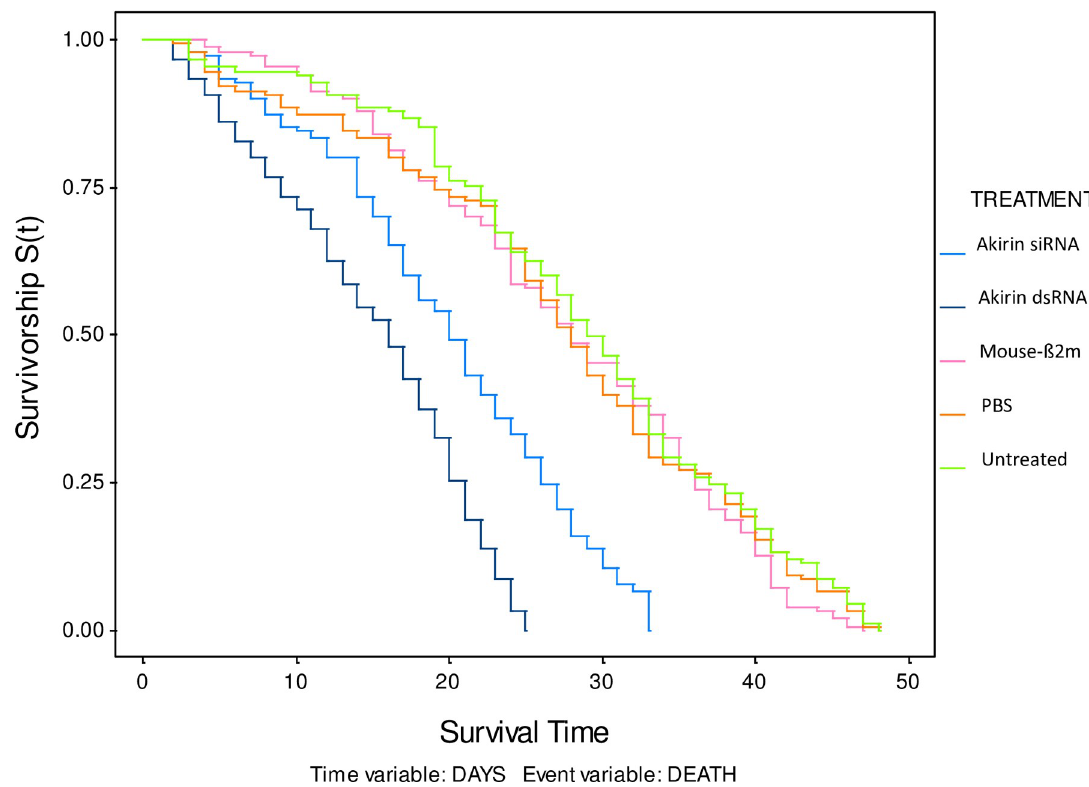
Fig 3. Kaplan-Meier survival analysis of Akirin knockdown (blue), Mouse-ß2m (pink), PBS (orange) and untreated (green) mosquitoes. Female mosquitoes treated with Akirin siRNA and Akirin dsRNA reached 100% mortality 15 and 23-days (respectively) before the control treatments, which conveyed a 32–48% decrease in vector longevity (Log-rank: χ 2 = 154, p < 0.01, DF = 4).